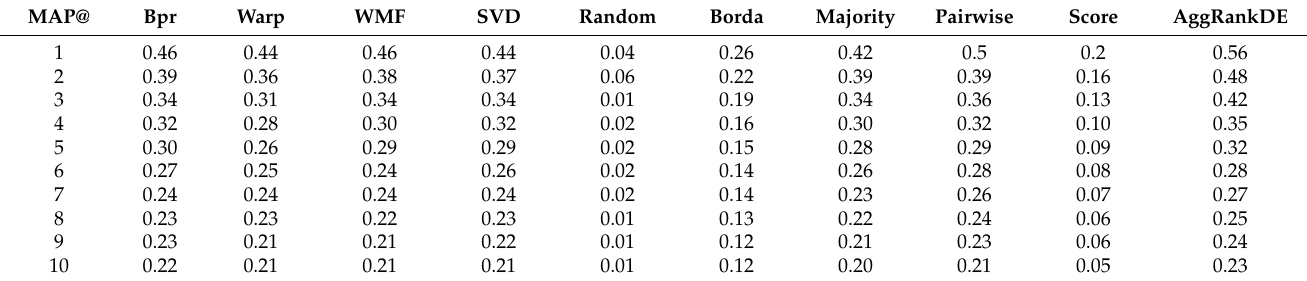
Table 9. The quality of the generated recommendations (MAP) for different MAP @ values for the best parameters presented in Table 1 with the additional RANDOM algorithm.